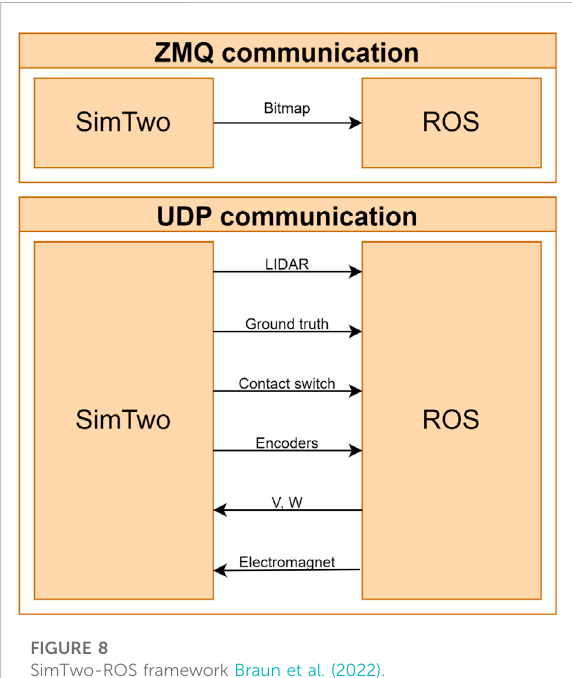
FIGURE 8 SimTwo-ROS framework Braun et al.